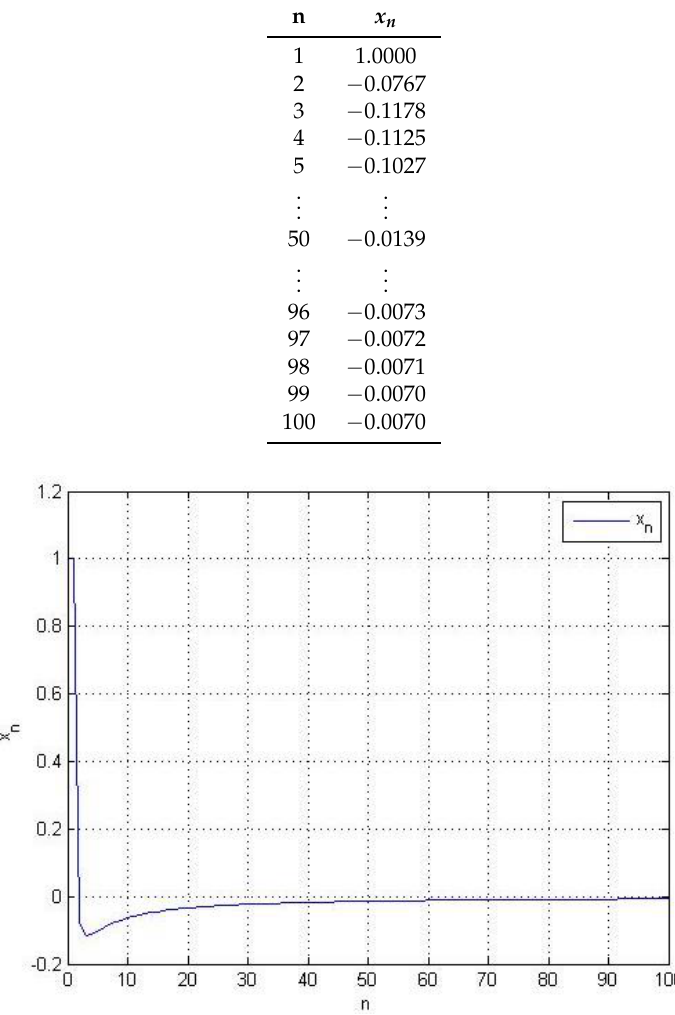
Figure 1. The sequence { x n } converges strongly to 0 with initial values x 1 = 1, N = 100 and n =